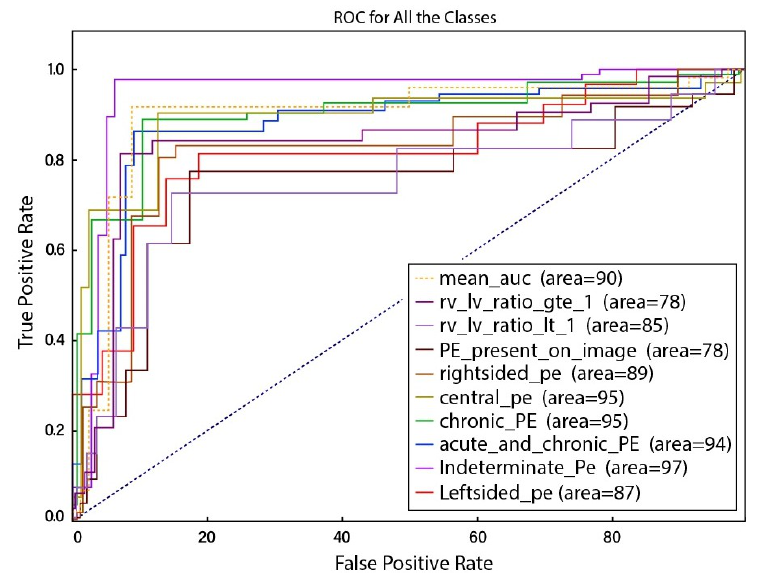
Figure 4. ROC curve for all of the classes.